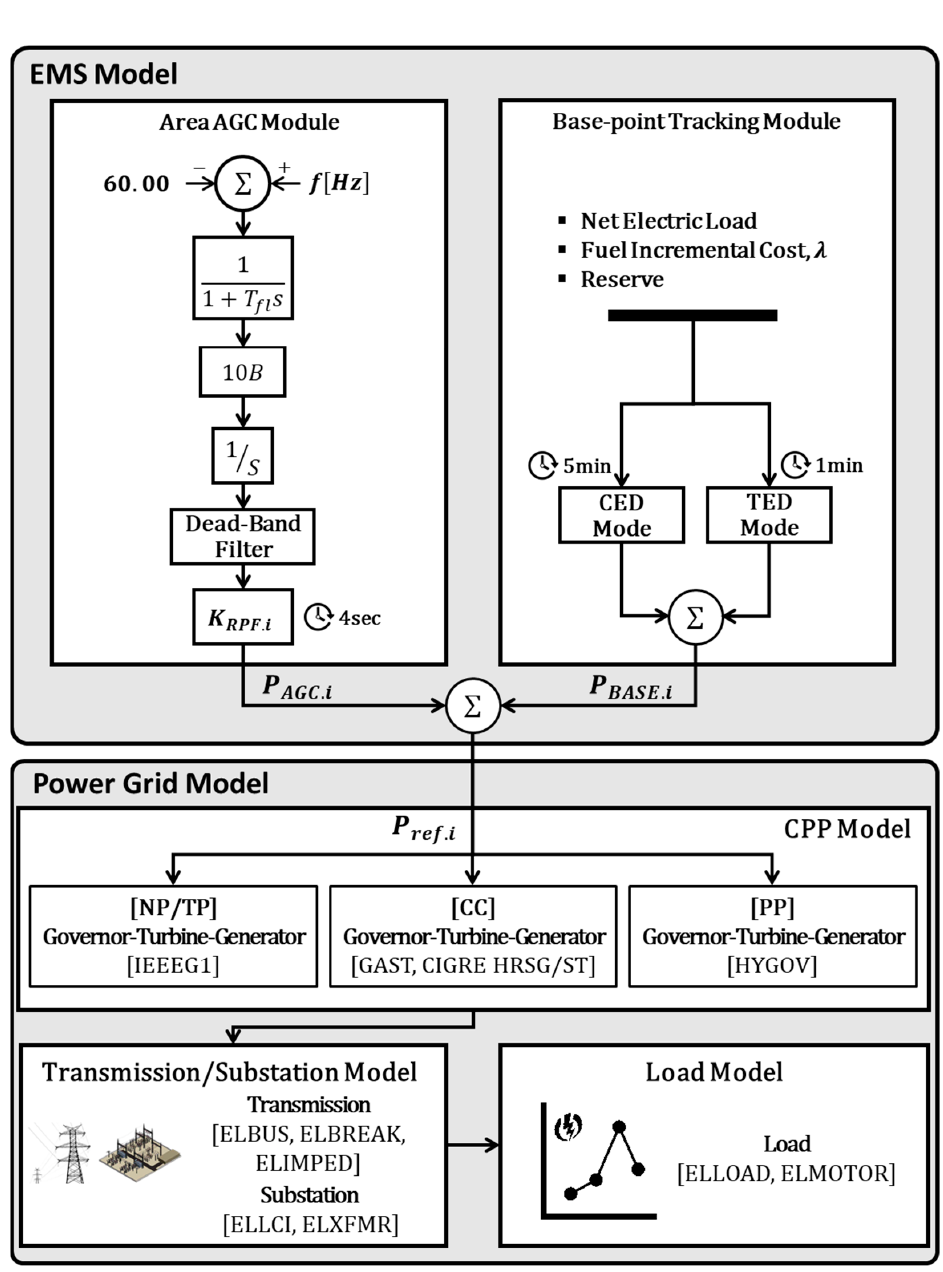
Figure 3. Main component and process of EMS model. The AGC participation rate of each CPP is calculated through the ramp rate 𝐾 (cid:3045)(cid:3028)(cid:3040)(cid:3043).(cid:3036) of the CPP model currently incorporated into the system, and as shown in Equation (4), basepoint P base . i . Equation (6) is the fuel cost equation F Eco of EcoLD, and Equation (7) the AGC response 𝑃 (cid:3002)(cid:3008)(cid:3004).(cid:3036) is delivered every four seconds.